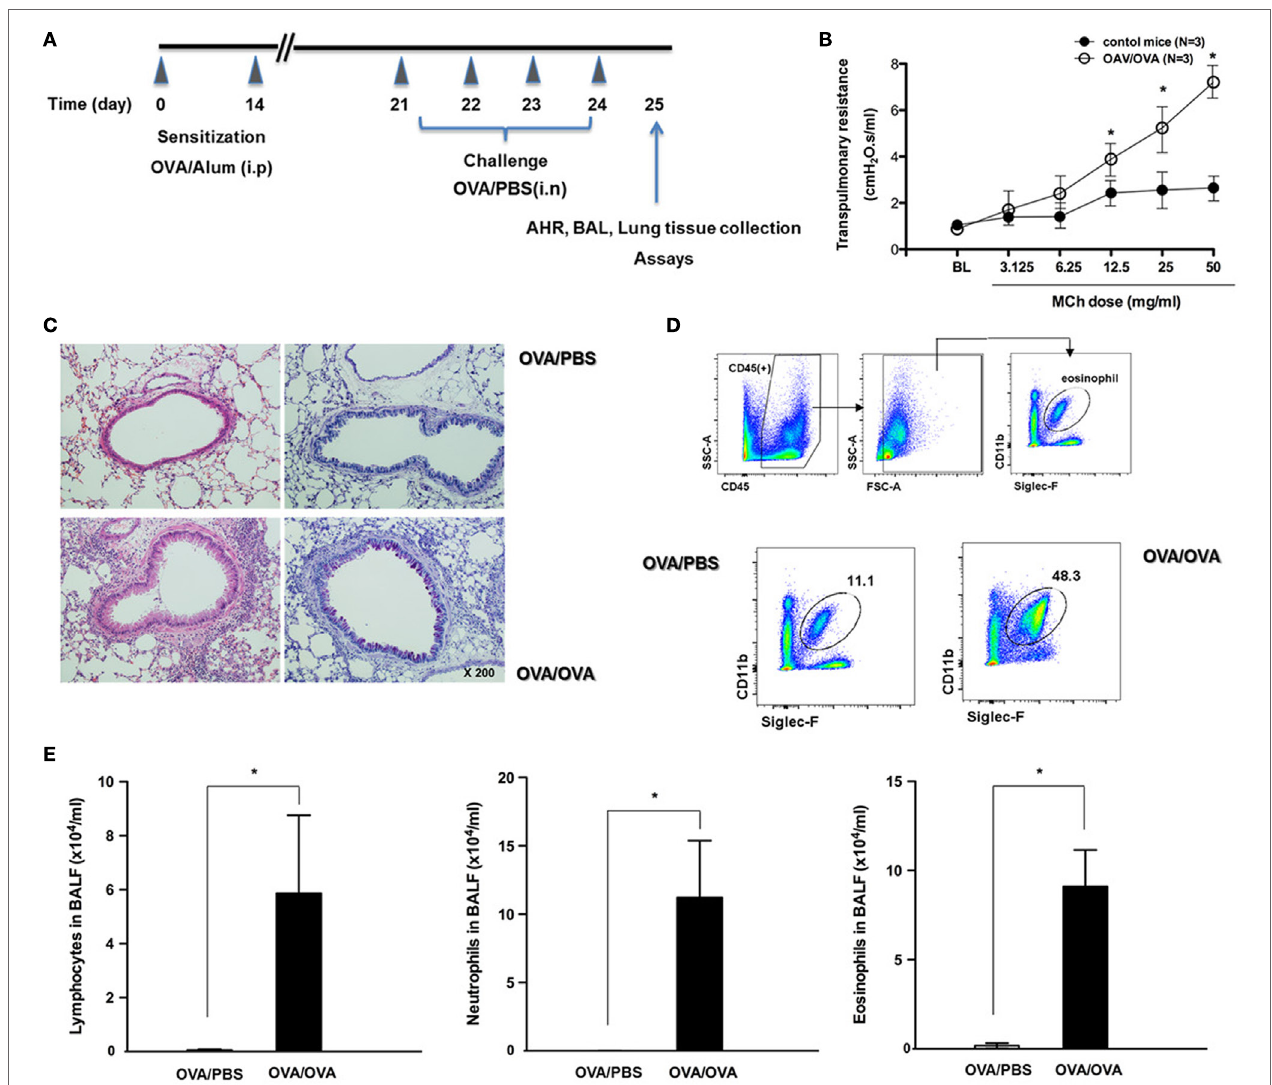
FigUre 1 | The development of allergic asthmatic mouse model. (a) The experimental protocol for development of allergic asthmatic mouse using C57BL/6. Non-asthmatic mice [OVA/phosphate-buffered saline (PBS), N = 5]. (B) Airway hyper-responsiveness was measured as methacholine-induced increases in transpulmonary resistance in mechanically ventilated mice. Data are expressed as mean value of percentage increased from base line of the transpulmonary resistance ± SD values of three mice (white dot: OVA/OVA, black dot: OVA/PBS). (c) Histological assessment of mucus secretion in asthmatic mice. Periodic acid Schiff-stained sections were assessed from five mice. (D) Flow cytometric analysis was done for isolation of eosinophils using anti-CD11c and anti-Siglec-F antibodies. (e) Bronchoalveolar lavage (BAL) fluid differential counts for lymphocytes, neutrophils, and eosinophils expressed as mean ±